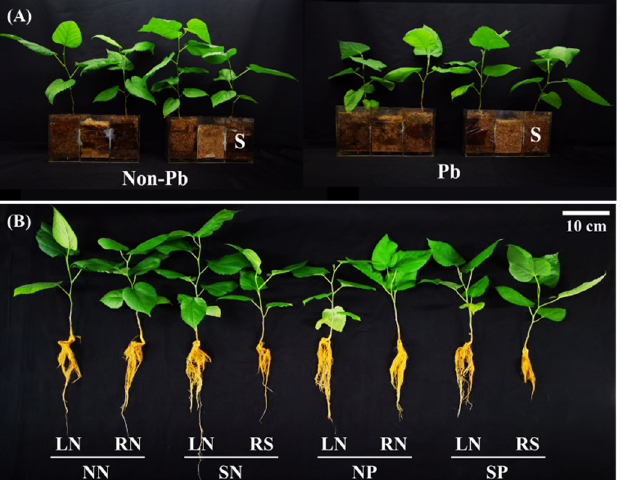
Figure 1. ( A ) The mulberries were shaded or unshaded in a three-compartment system and applied with/without Pb. S = shaded mulberry. ( B ) The mulberries were shaded or unshaded and applied with/without Pb. NN = unshaded treatment without Pb applied, control treatment; SN = shaded treatment without Pb applied; NP = unshaded treatment with Pb applied; SP = shaded treatment with Pb applied. LN = no Pb was added in the left unshaded mulberry; RN = the right unshaded mulberry without Pb added in the hyphal compartment; RS = the right shaded mulberry with Pb added in the hyphal compartment.